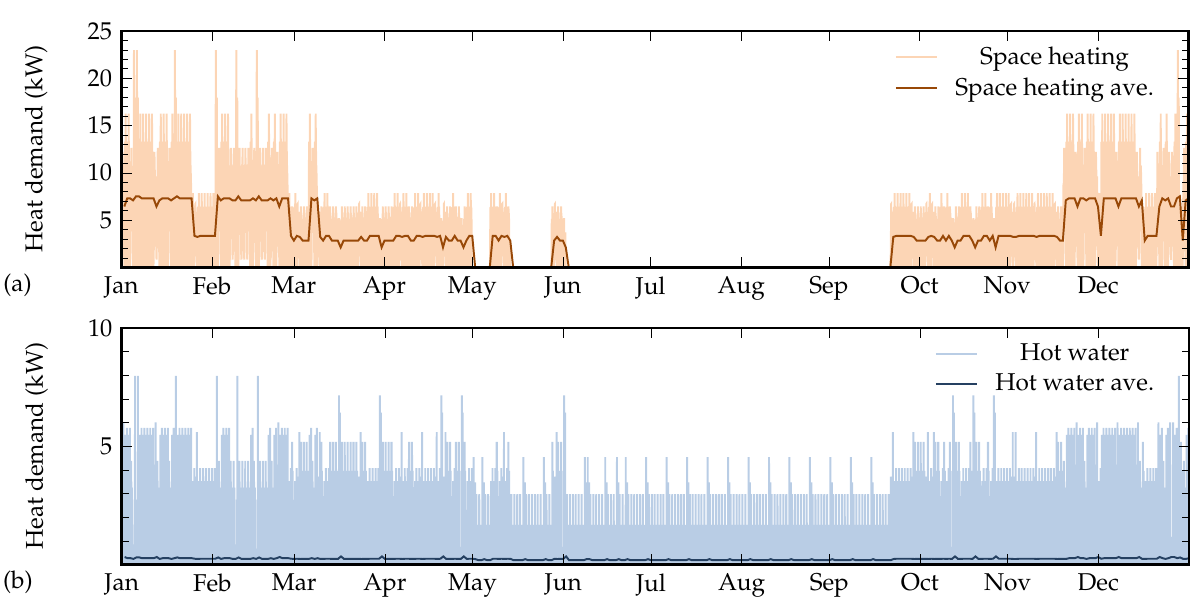
Space heating ave.